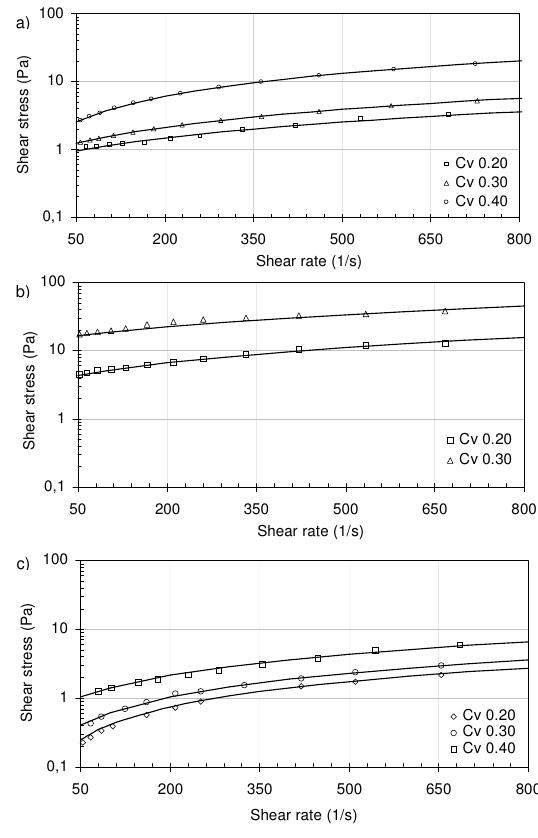
Fig. 6. Experimental data and theoretical flow curves at different volumetric concentration C v : (a) material A; (b) material B; (c) ma- terial C.